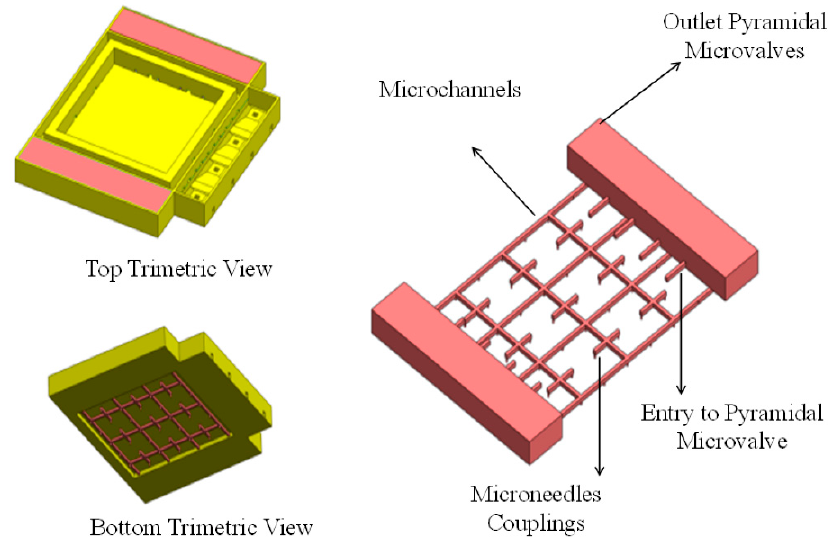
Figure 2. Fluid volume discharge structure.